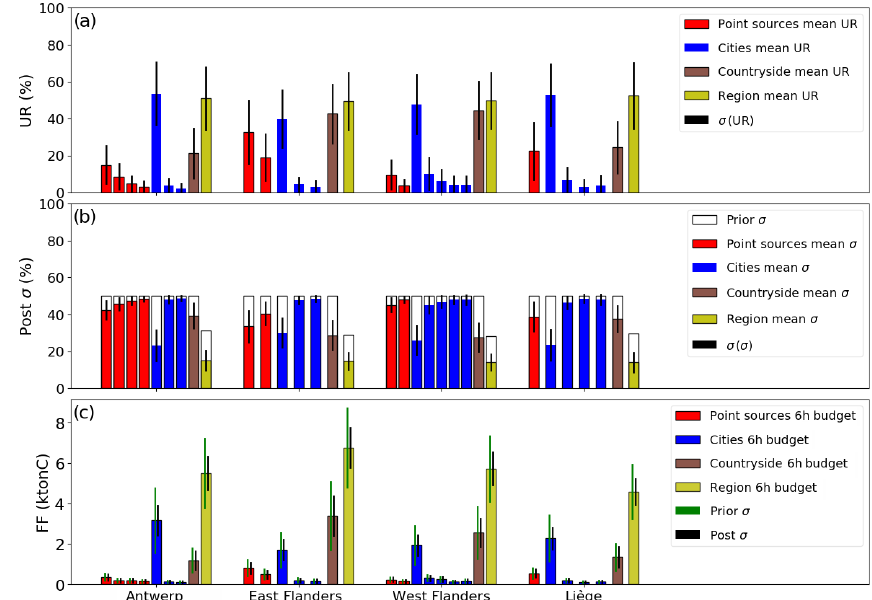
Figure 8. (a) Mean values and standard deviations of the uncertainty reductions (UR) for the regions, point sources, urban and countryside areas constituting four Belgian regions. Averaging is performed across the 62 inversion results for the days of March and May 2016. (b) Mean values and standard deviations of the relative post-uncertainty for each emitting area. Prior uncertainties are represented as well. Prior uncertainties in the regional budgets are derived by aggregation of the prior uncertainties of their constituent emitting sources (mean value ∼ 33%). Panel (c) shows the mean 6h budgets for each emitting area. The inversions are performed with a retrieval resolution of 2km × 2km, a precision of 0.6ppm and a swath of 900km. Prior uncertainties on the 6h budgets of the point sources, urban and countryside areas are taken to be equal to 50%, and prior error correlations between hourly emissions have a temporal length of